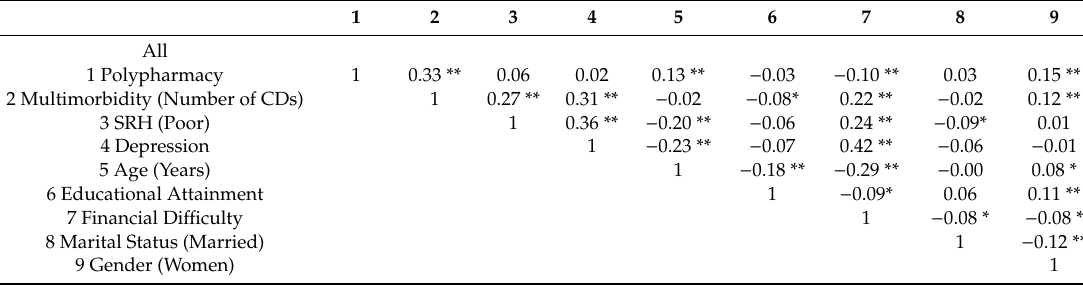
Table 2. Bivariate associations between study variables overall and by